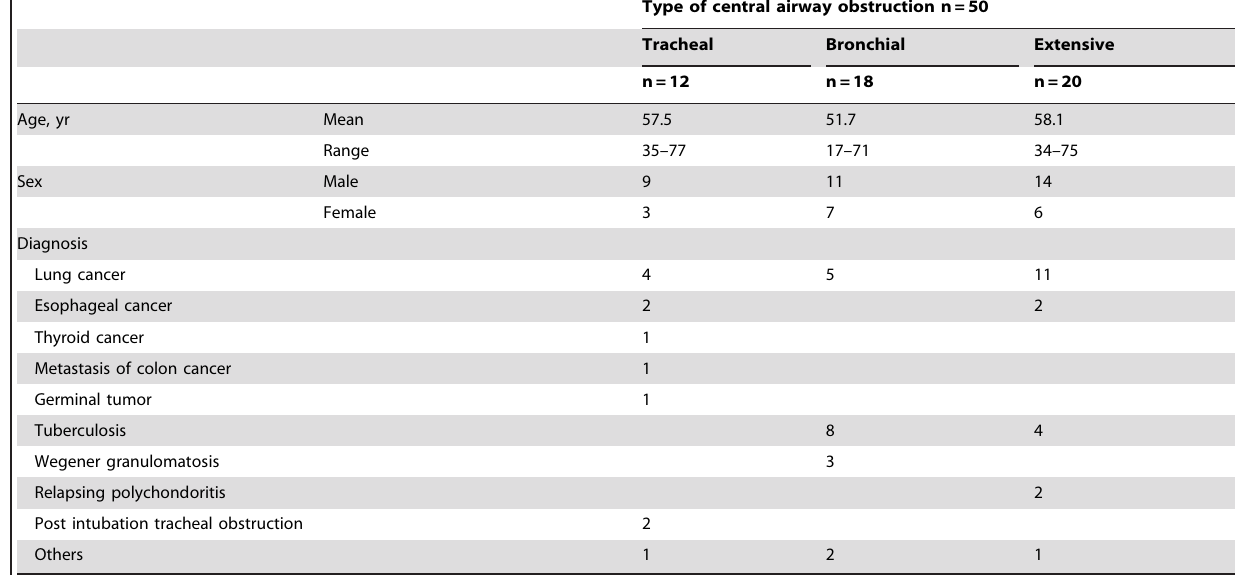
Table 1. Characteristics of patients with central airway obstruction.